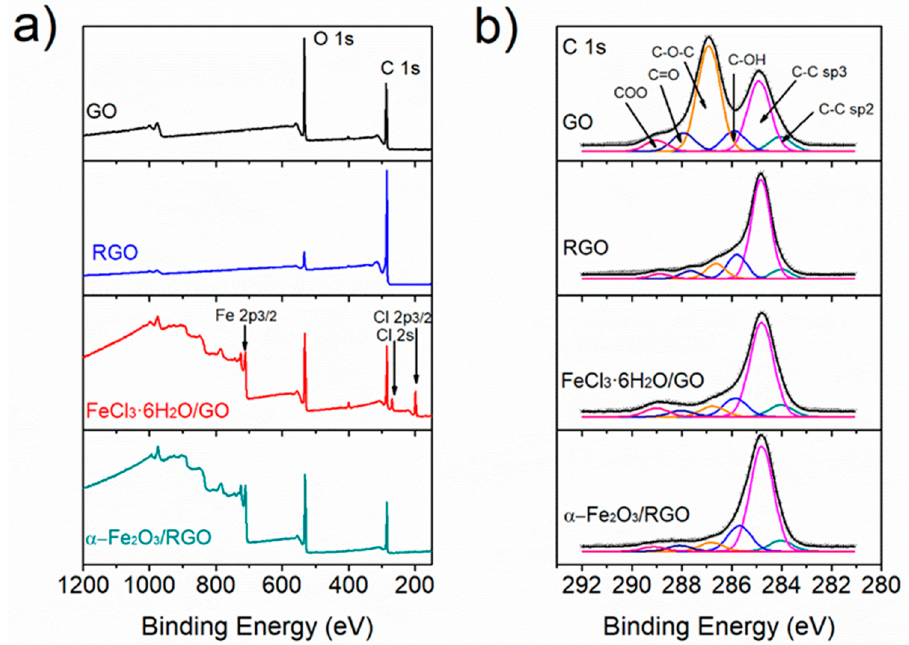
Figure 4. X-ray photoelectron spectroscopy (XPS) analysis of GO, RGO, FeCl 3 · 6H 2 O/GO, and α -Fe 2 O 3 /RGO hybrid material. ( a ) Survey spectra and ( b ) spectra of C 1s core. The spectra C 1s core for GO, RGO, FeCl 3 ∙ 6H 2 O/GO, and α -Fe 2 O 3 /RGO (Figure 4b) were deconvoluted into six components at 284 eV, 284.8 eV, 285.7 eV, 286.8 eV, 288.1 eV, and 289.1 eV